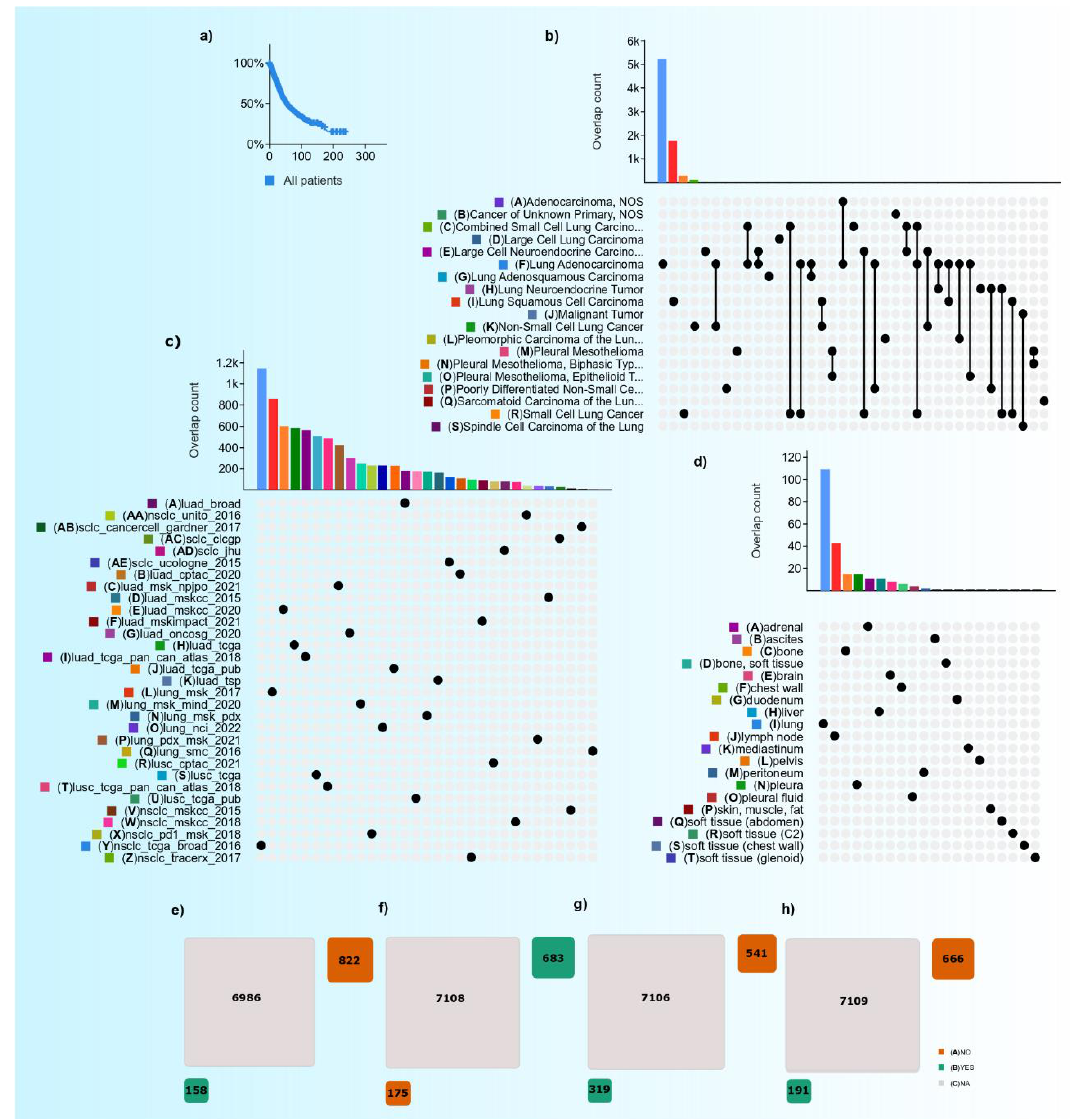
Figure 1. TCGA-cbioportal data on LC. ( a ) KM plot of the LC cases with five-year overall survival: x-axis (% event free), y-axis (time of event in months). ( b ) Frequency of LC histotypes with the overlap in different studies. ( c ) LC projects registered with TCGA. ( d ) PD-L1 tissue site expression in LC cases. ( e – h ) Patient records who availed therapies, including radiation therapy, chemotherapy, targeted therapy, and immunotherapy, respectively (Data source: https://www.cbioportal.org (accessed on 1 July